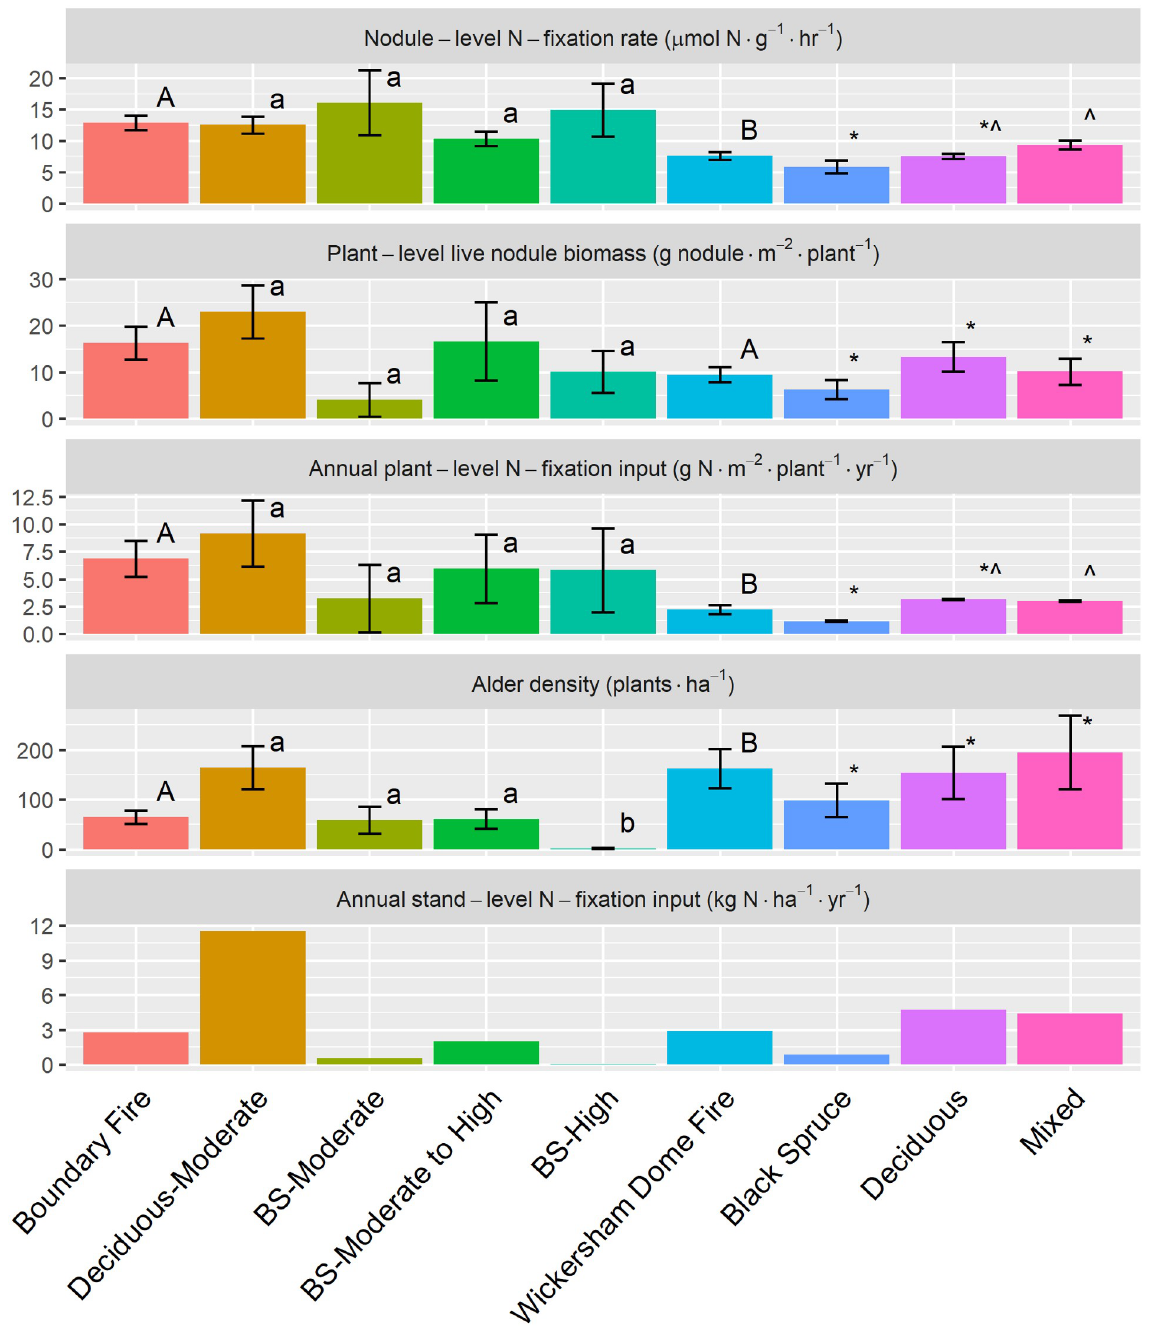
Fig 1. Siberian alder nodule productivity, plant-level N-input, plant density, and stand-level N-fixation input in the Boundary Fire (n = 19), Wickersham Dome Fire (n = 21), and stand types within each burn scar. Significant differences are determined at p < 0.05 between burn scars (A or B), and among stand types of the Boundary Fire (a or b) and Wickersham Dome Fire ( � or ^). Graph order from top to bottom: nodule-level N-fixation rate ( μ mol N g -1 hr -1 ), plant-level live nodule biomass (g nodule m -2 plant -1 ), annual plant-level N-fixation input (g N m -2 plant -1 yr -1 ), alder density (plants ha -1 ), and annual stand-level N-fixation input (kg N ha -1 yr -1 ).